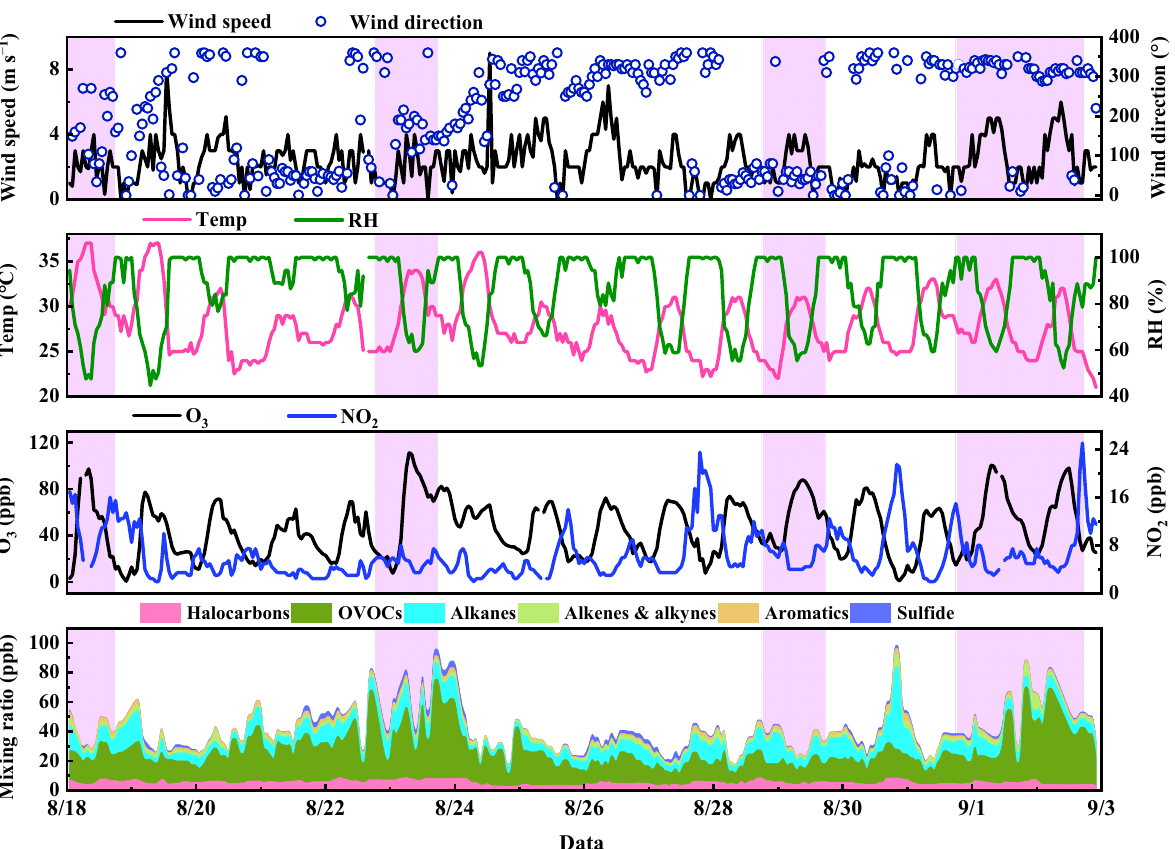
Figure 2. Time series of wind speed, wind direction, temperature (Temp), relative humidity (RH), O 3 , NO 2 , and VOCs during the observation period. The pink bars in the figure represent the O 3 pollution episodes during the observation period.